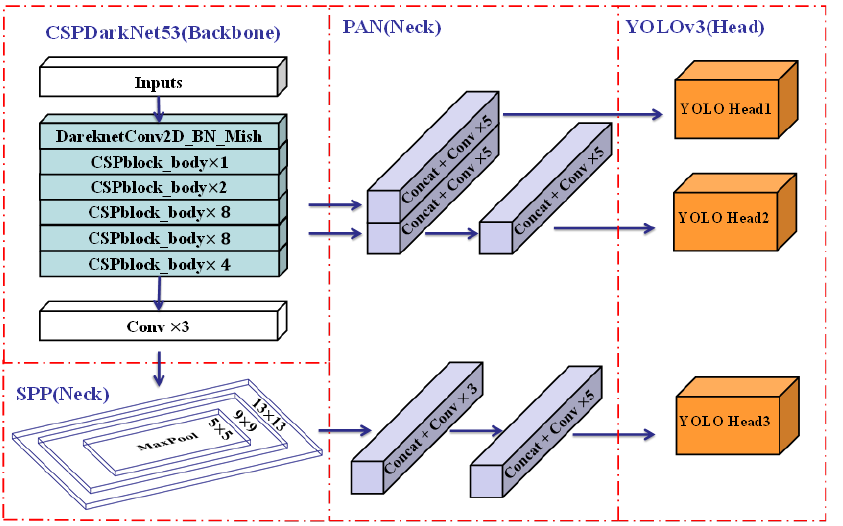
Figure 5. Architecture of YOLOv4. CSPDarknet53 (Backbone): Cross Stage Paritial Network. SPP(Neck): Spatial Pyramid Pooling. PAN(Neck): Path Aggregation Network.